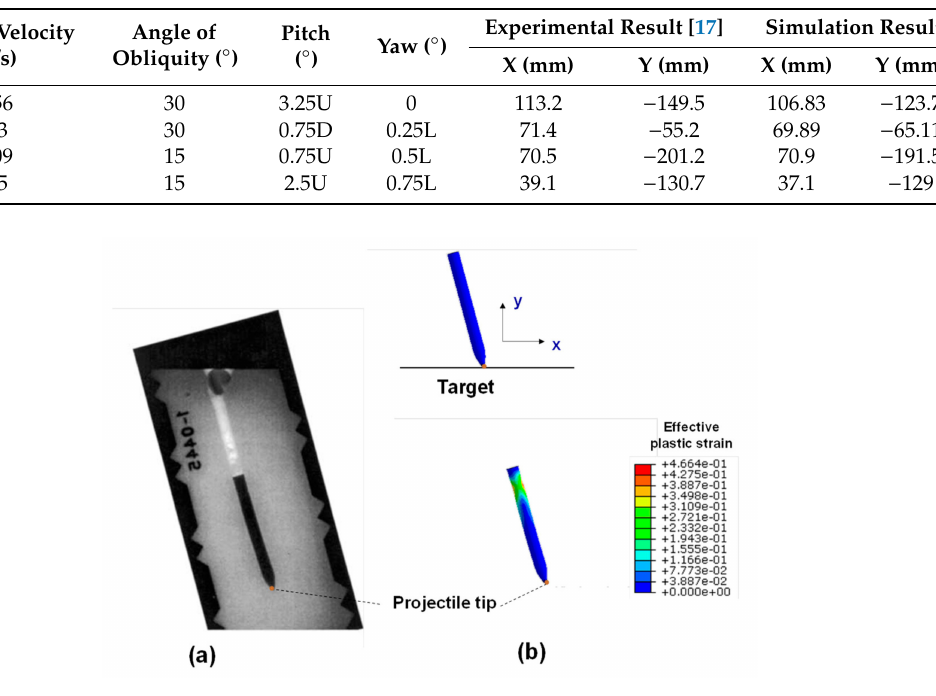
Figure 9. Final deformed shape after impact for V = 985 m / s, 15 ◦ angle of obliquity: ( a ) Experimental result [17] ( b ) Simulation